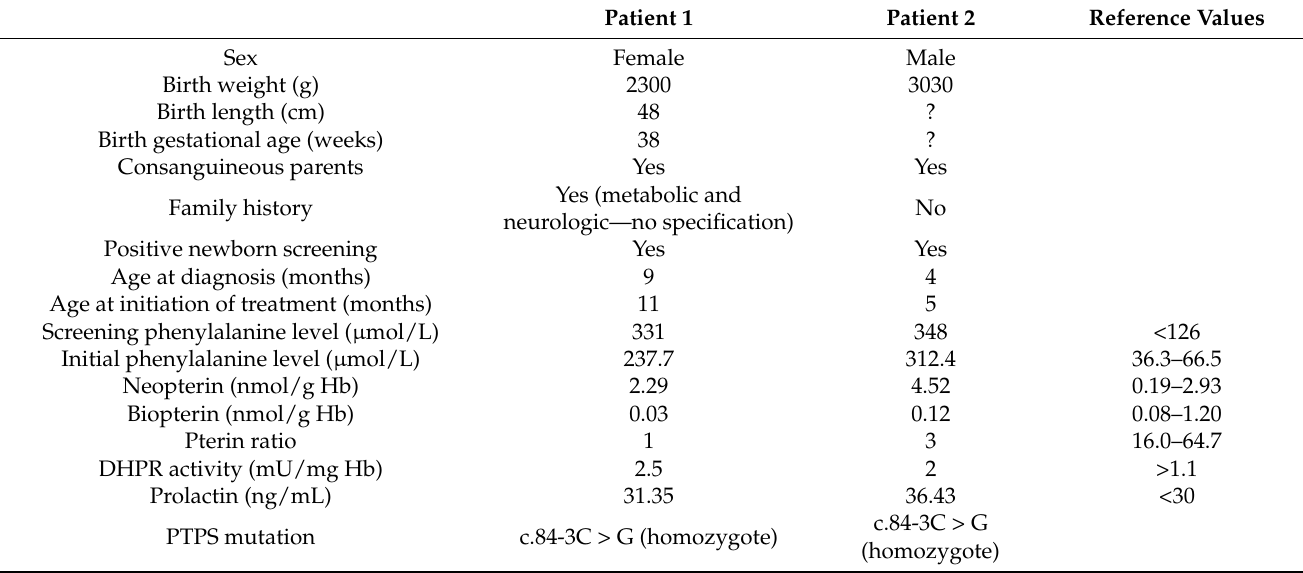
Table 1. Demographic, biochemical, and genetic description of our patients. Patient 1 Patient